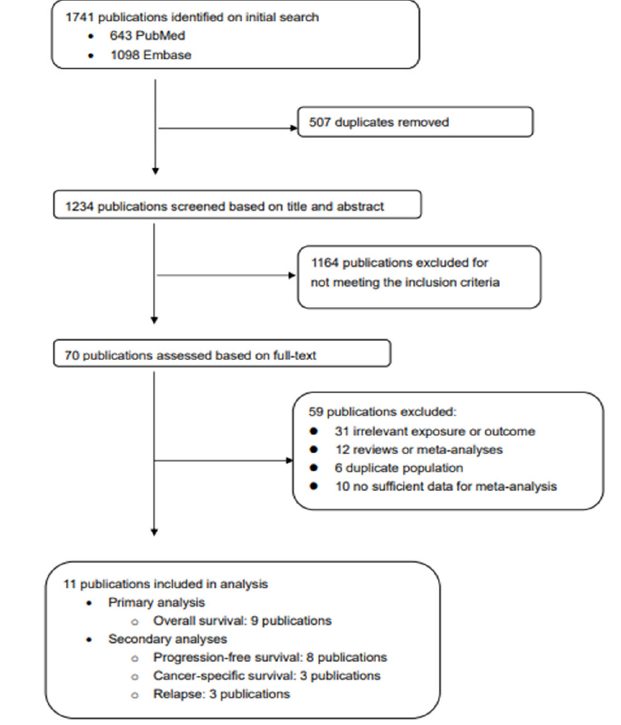
Figure 1. Flowchart for study selection.